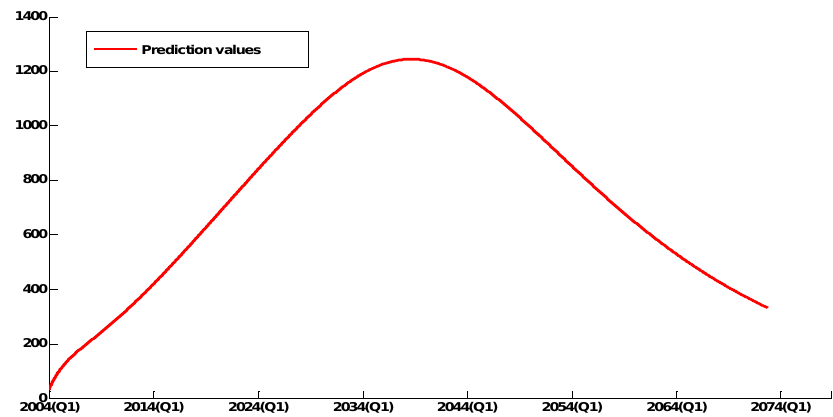
Figure 6. The tendency prediction of human Echinococcosis cases over a period of 60 years.